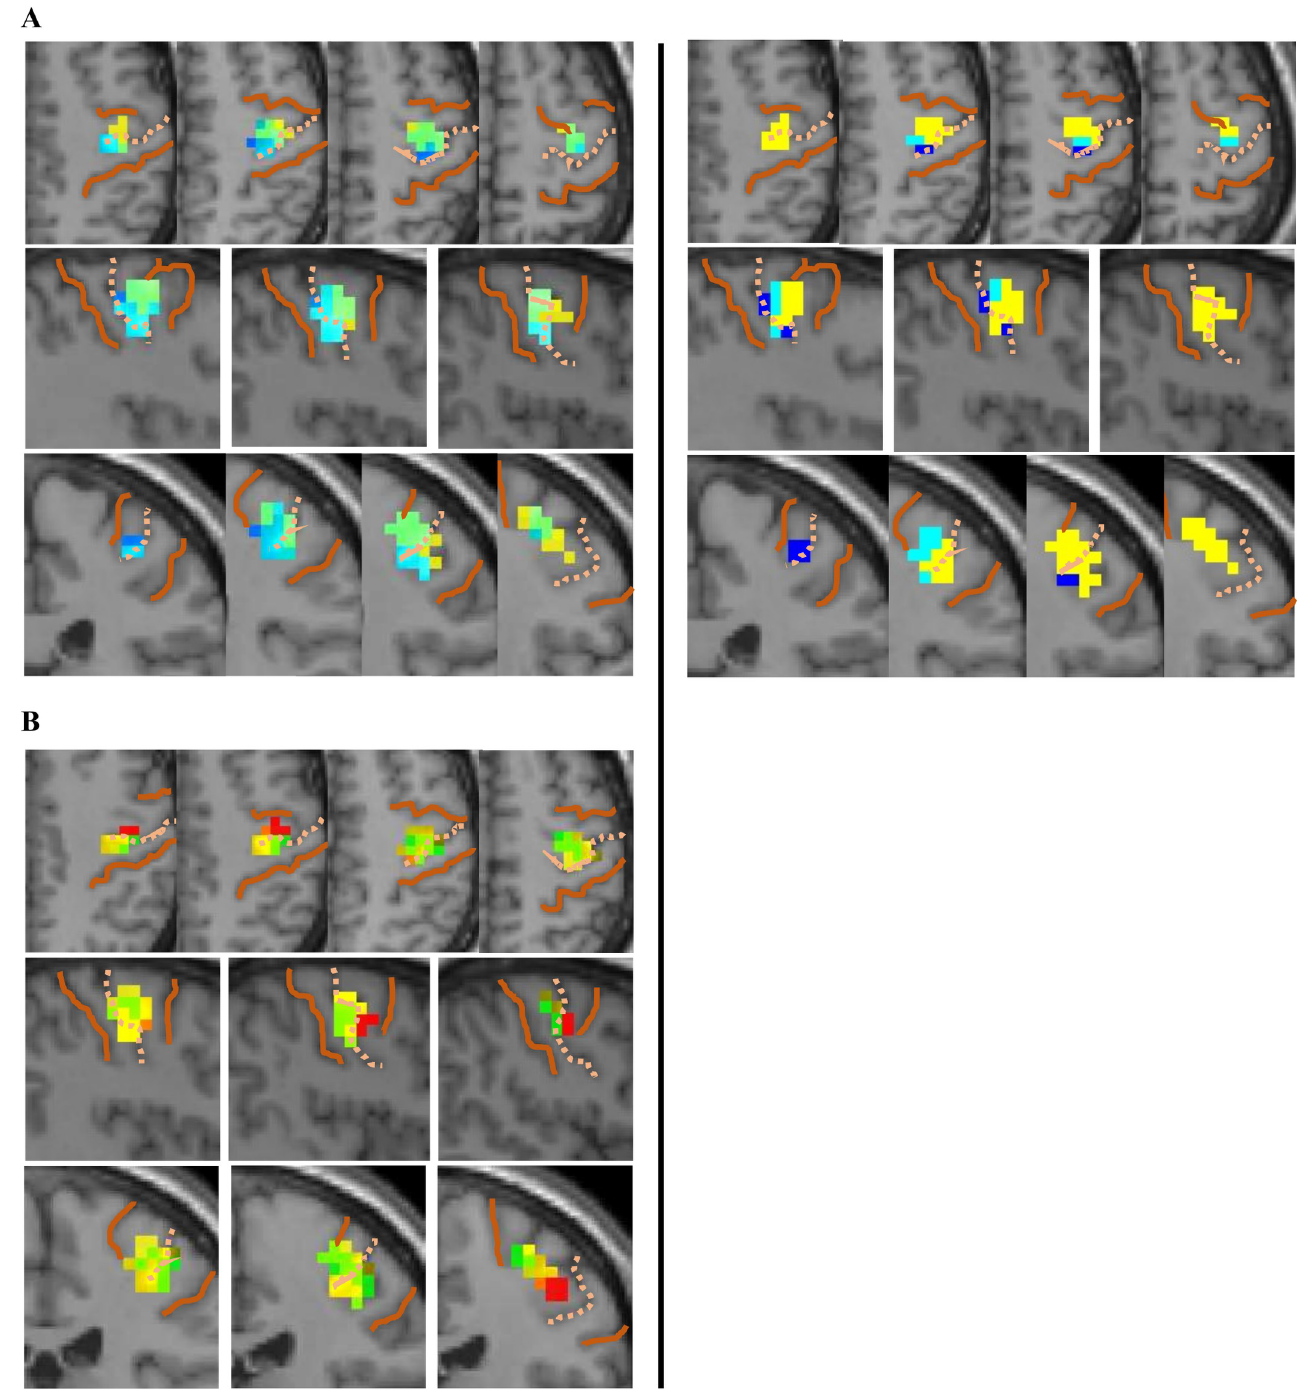
Fig 7. Topographical hippocampal connectivity from individual voxels during repetitive tapping. (A) Connectivity maps from three central voxels along the medial-lateral plane. Overlapping connectivity from adjacent voxel maps is shown on the left; differential connectivity is shown on the right (lateral > middle seed connectivity in dark blue, middle > medial seed connectivity in cyan, medial seed connectivity in yellow). Selected seeds are second, fourth, and sixth voxel from the medial edge of the hippocampus (from a breadth of six 4mm-isovoxels), representing structural seeds B1, B2 and B3. (B) Connectivity maps from three medial voxels along the longitudinal plane; anterior seed is red, middle is yellow, and posterior is green. Selected voxels are the second, fifth, and eighth from the anterior edge of the hippocampus (from a length of nine 4mm isovoxels), representing structural seeds A1, B1, and C1. Conventions as in Fig 4.